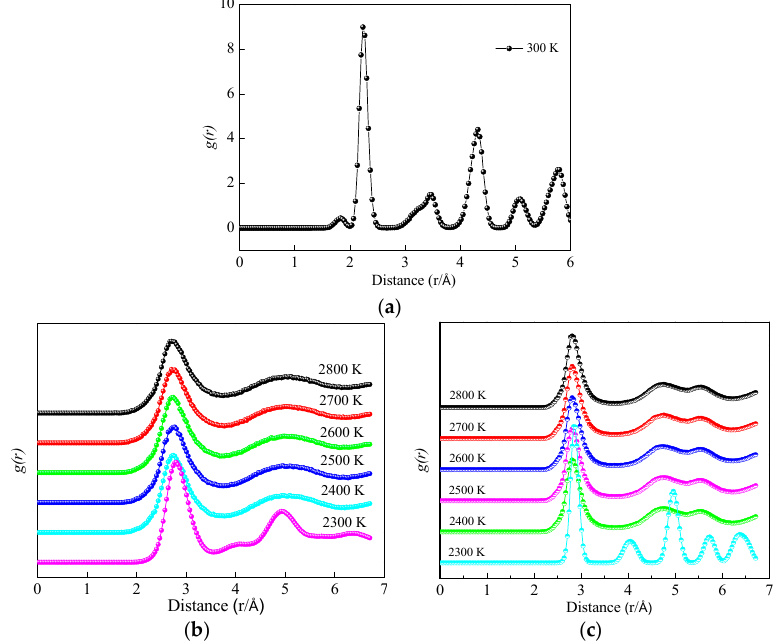
Figure 4. Radial distribution function curves of the Ti-Al alloy under different temperature conditions: ( a ) radial distribution function curve of Ti-Al alloy at 300 K, ( b ) radial distribution function curves of Ti-Al alloy at different heating temperatures, ( c ) radial distribution function curves of Ti-Al alloy after heating to different temperatures and cooling to room temperature.